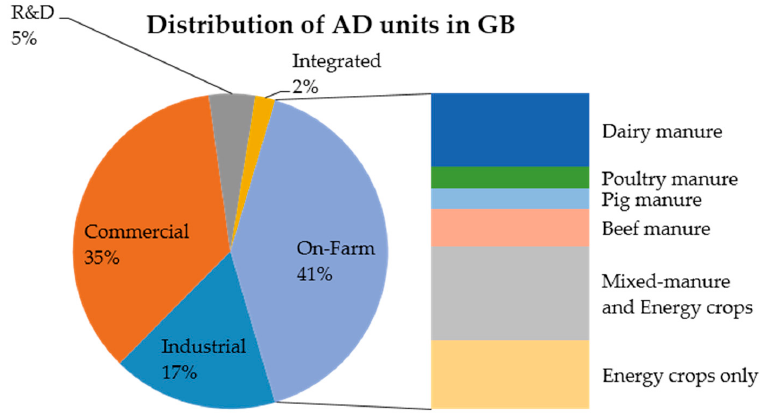
Figure 1. Sectors employing anaerobic digesters (AD) units in Great Britain (GB) [8].